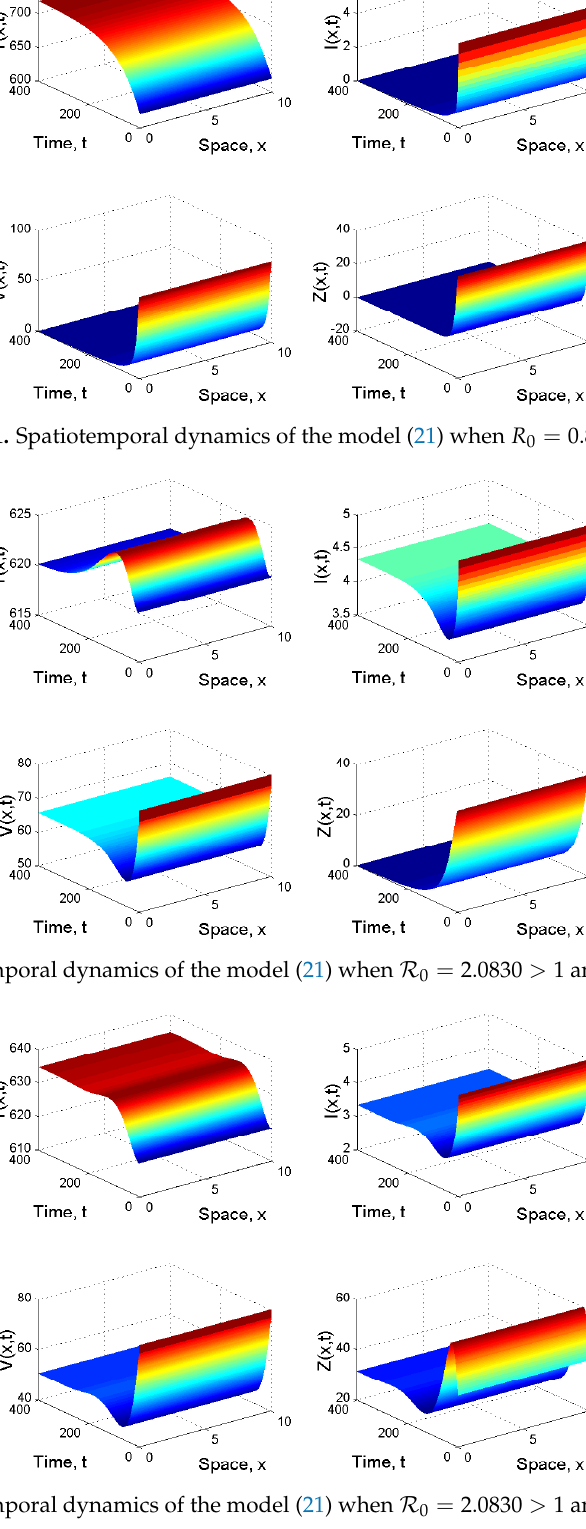
Figure 3. Spatiotemporal dynamics of the model (21) when R 0 = 2.0830 > 1 and R Z